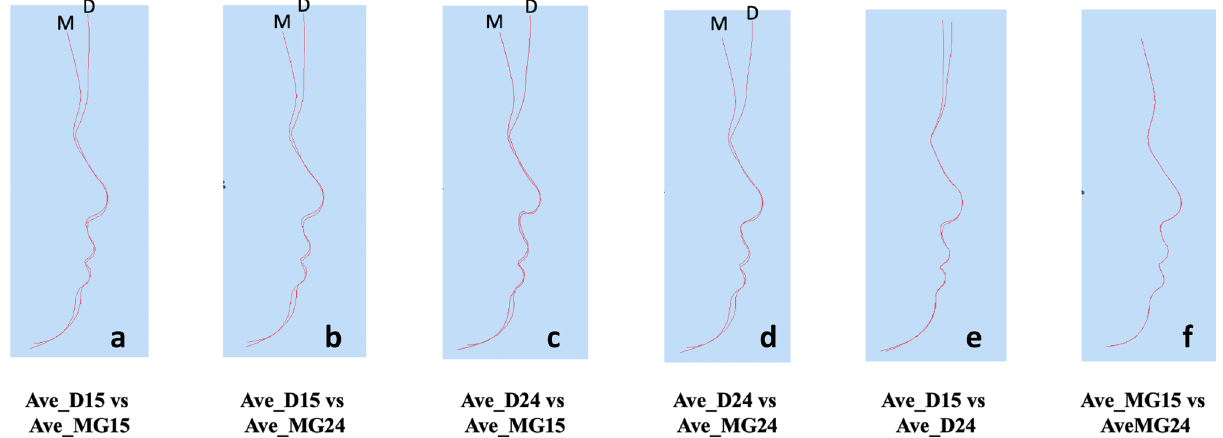
Figure 7. Profile cross-sections between the four different average facial mesh combinations following superimposition on the centroids of each of the average facial meshes. ( a) Ave_D15 vs Ave_MG15, ( b) Ave_D15 vs Ave_MG24, ( c) Ave_D24 vs Ave_MG15, ( d) Ave_D24 vs Ave_MG24, ( e) Ave_D15 vs Ave_D24, ( f) Ave_ MG15 vs